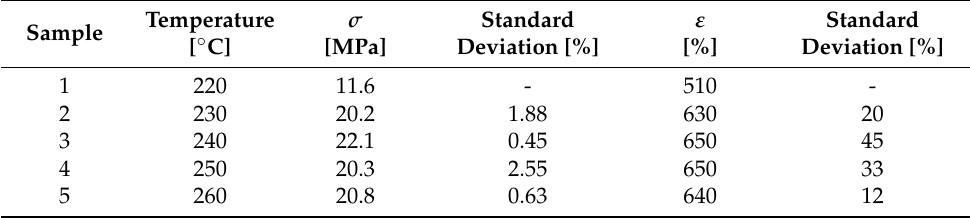
Table 3. Strength data of differently processed 3D printed tensile specimens of type 5A according to ISO 527, average values obtained with three